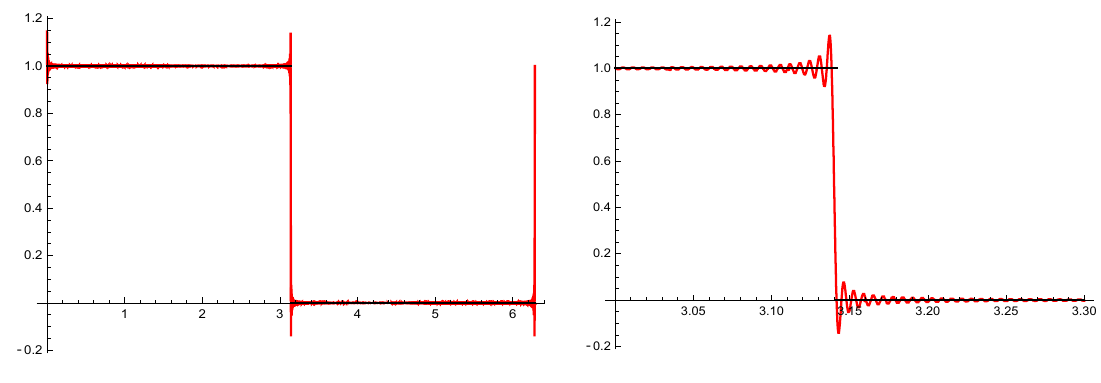
Figure 5. F ( e i θ ) and (cid:60) ( L − n , n − 1 ( F , e i θ )) with F ( z ) = χ S ( z ) , z = e i θ , θ ∈ [ 0,2 π ] , θ ∈ [ 3,3.3 ] and n =